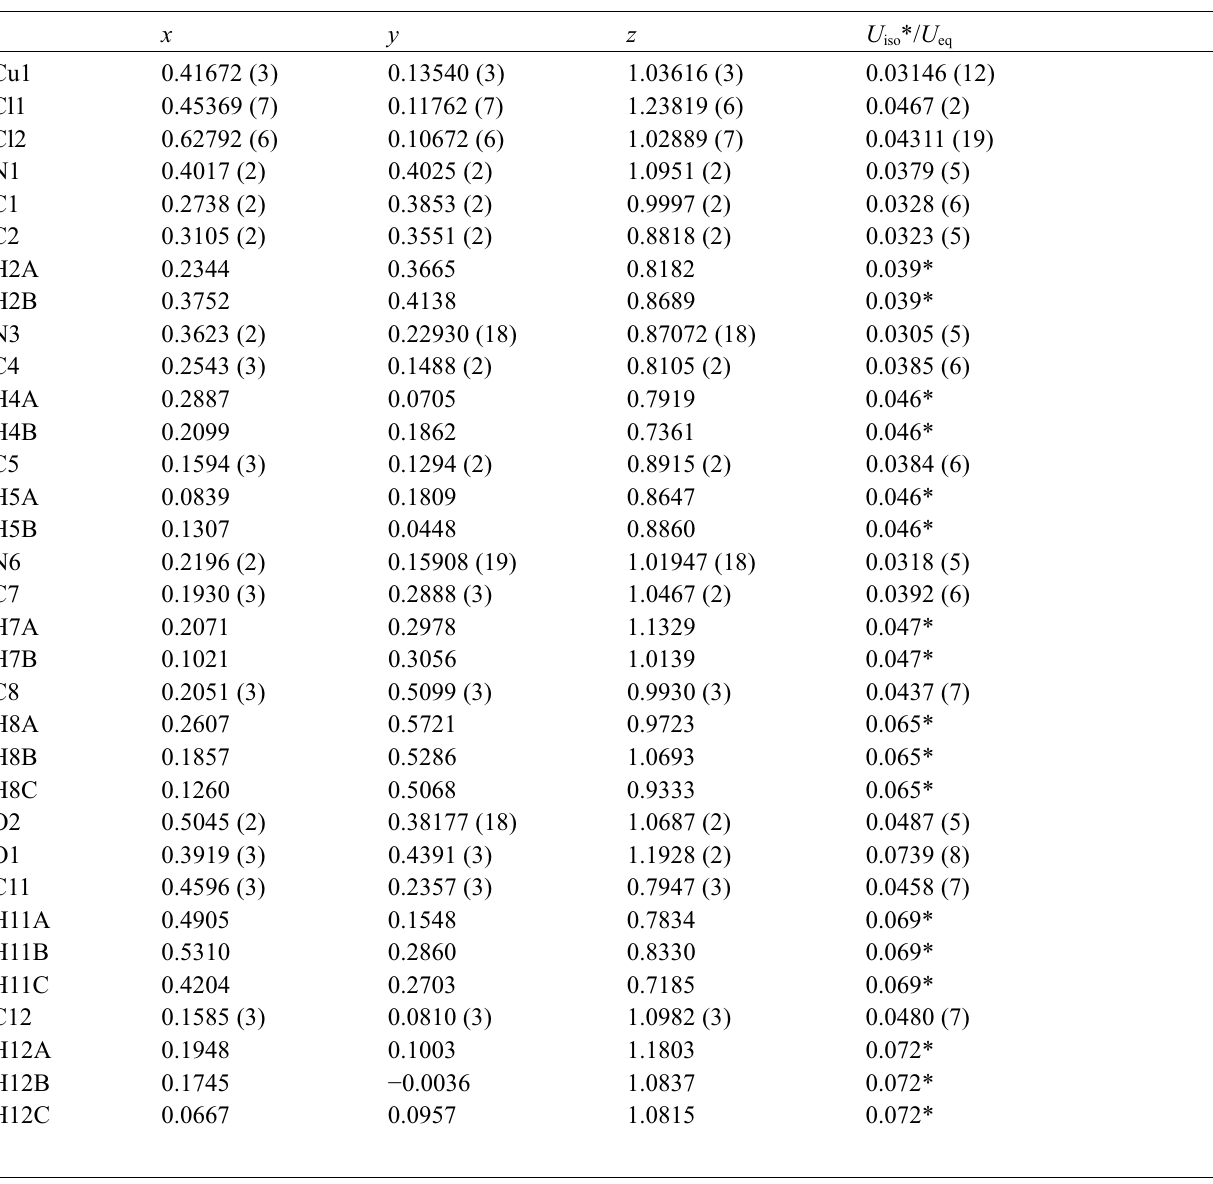
Experimental . Absorption correction: SADABS (Bruker, 2006) was used to scale the data and to perform the multi-scan semi-empirical absorption